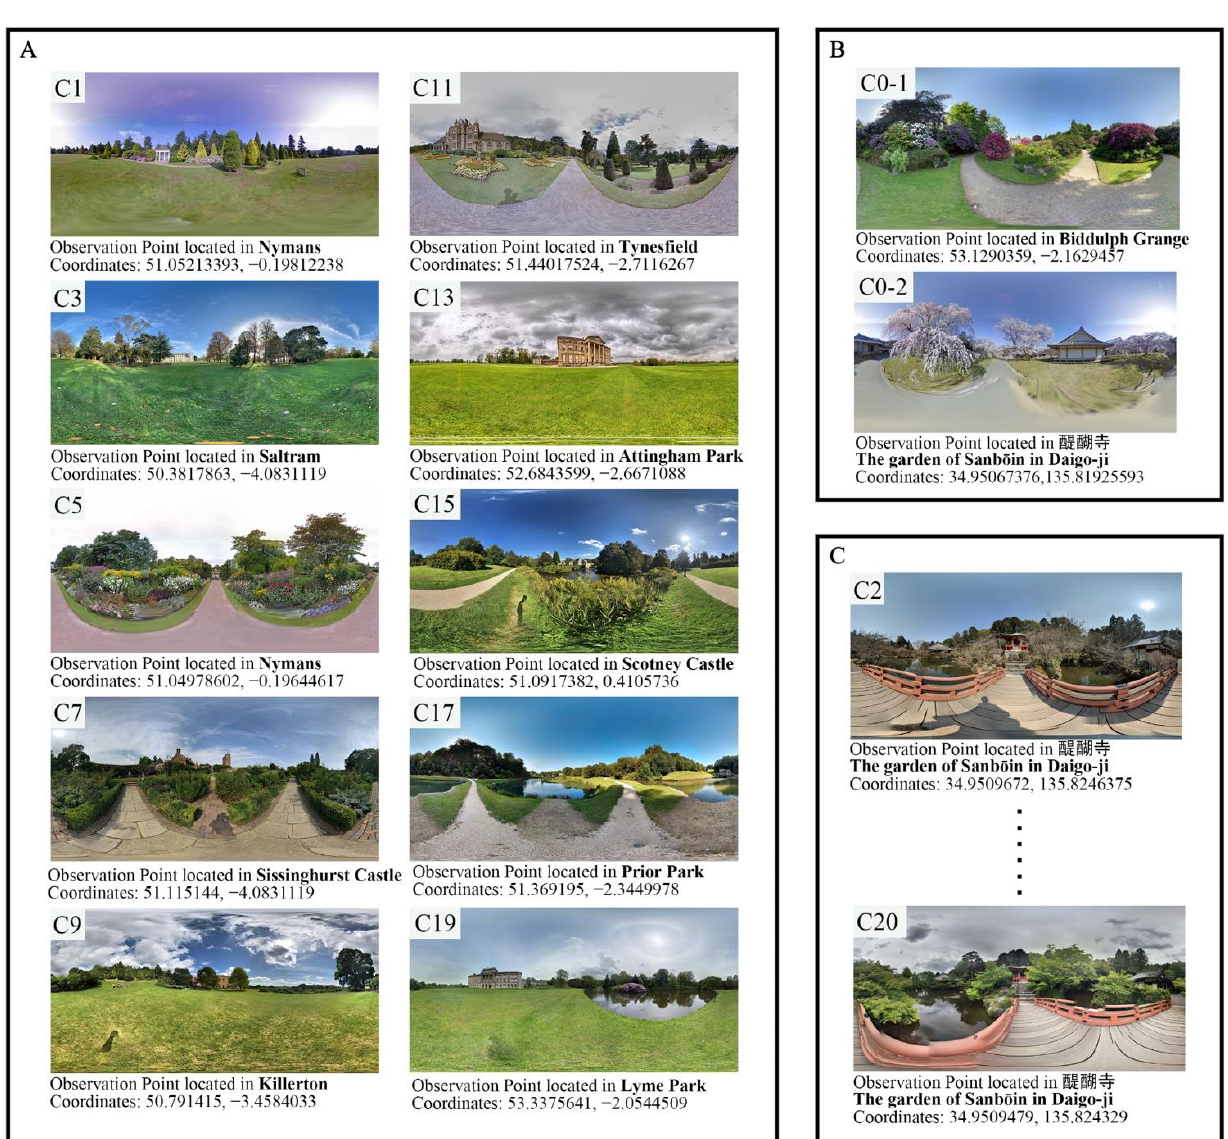
Figure 1. Panoramas taken from the selected observation points were used to create ( A ) primary stimulation, ( B ) practice trials, and ( C ) auxiliary stimulation. The first and final panoramas of ( C ) auxiliary stimulation were captured at a location that was nearly identical but during a different time of year. The “CX” symbol in the upper left corner of each panorama, which is a reference to Table 3, indicates the display order of the associated video clips.